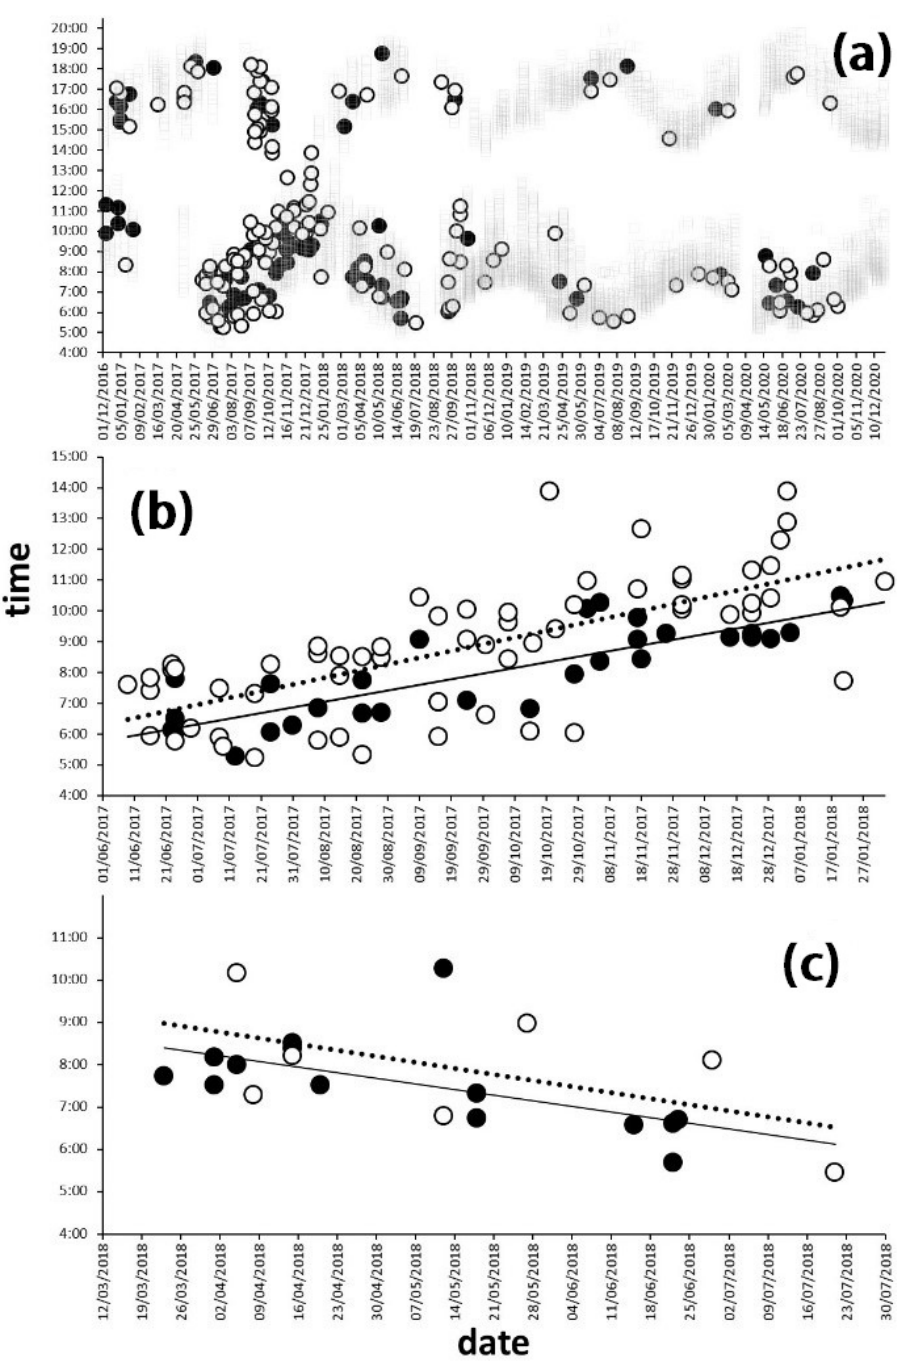
Figure 5. Observation times of the Iberian hare ( Lepus granatesis ) (black dots) and rabbit ( Oryctolagus cuniculus ) (white dots) during the period in which quantitative surveys were taken between December 2016 and December 2020. ( a ) The grey squares represent every sampling point. ( b ) Only morning surveys between June 2017 and February 2018. ( c ) Surveys taken before noon, between March and July 2018. In ( b , c ), the adjustments between date and time are represented by a solid line for hares and a dotted line for rabbits.